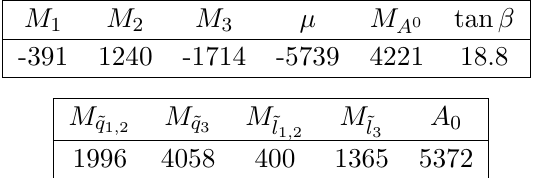
Table 1. The pMSSM11 parameter values (in GeV) of Point A.